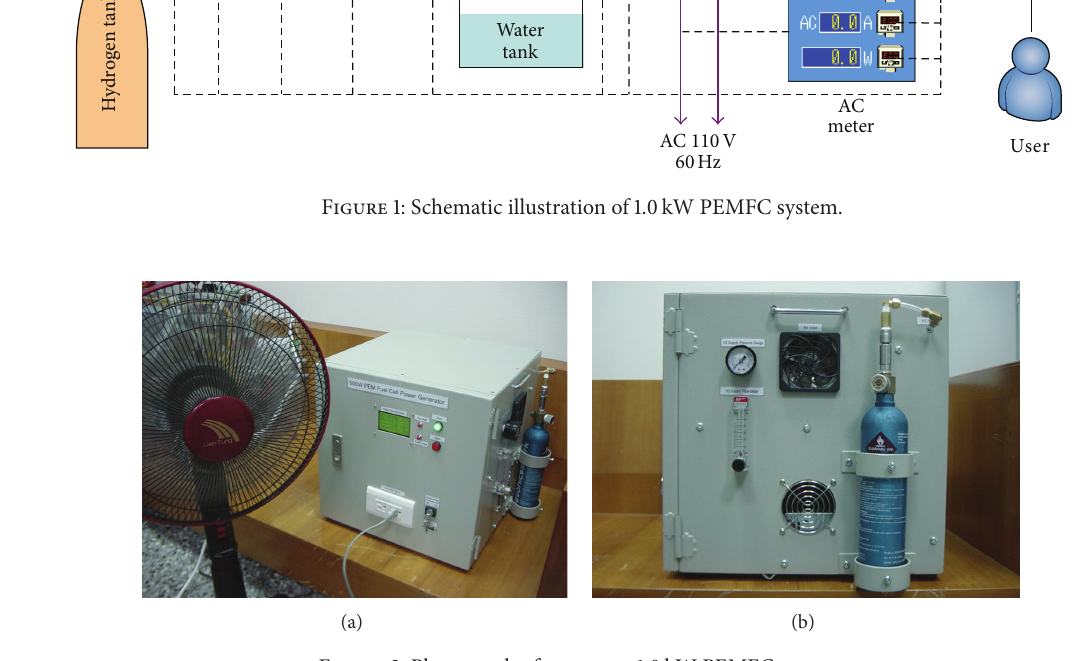
Figure 2: Photograph of prototype 1.0 kW PEMFC system.